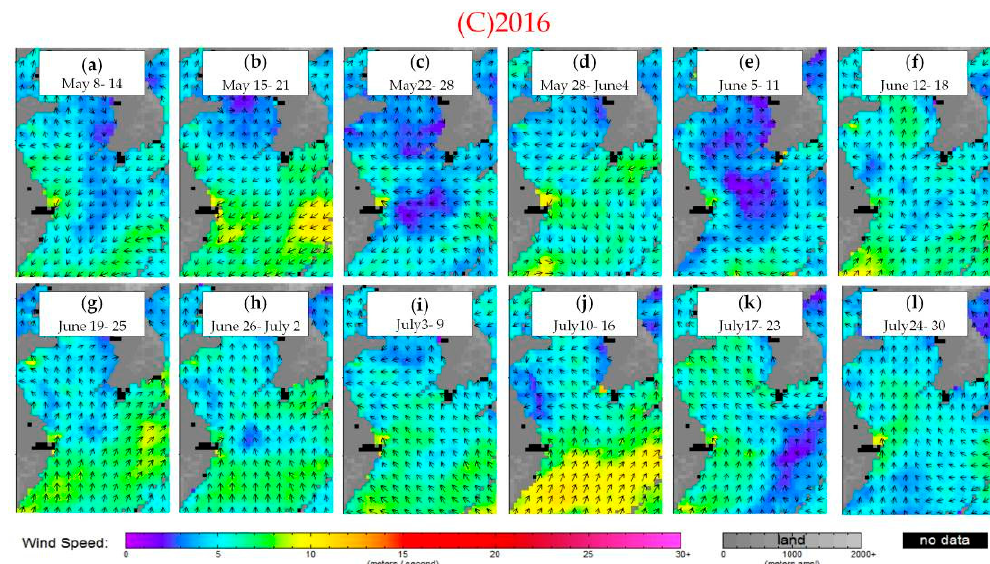
Figure 15. ( A ) Weekly average surface wind speed and direction from early June to mid-August in 2018. ( B ) Weekly average surface wind speed and direction from late April to July in 2017. ( C ) Weekly average surface wind speed and direction from early May to July in 2016. Dara was obtained from remote sensing systems (RSS), http://www.remss.com/. Remote Sensing Systems is supported by NASA, NOAA, and the NSF, offering research quality products of sea surface wind speed and direction and other products for use in research and climate study.